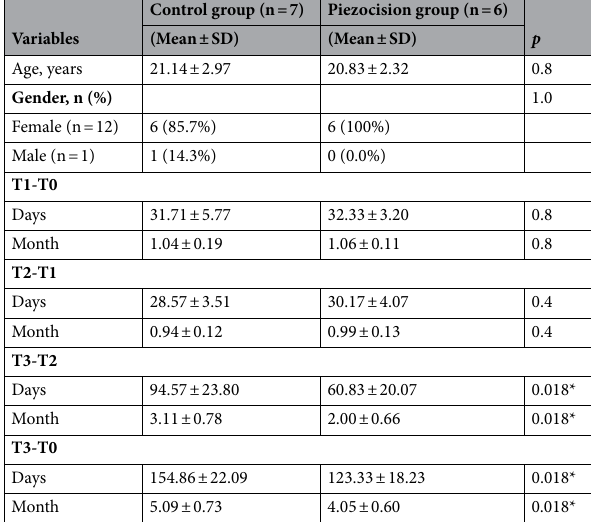
Table 1. Sample demographic and baseline. *Significant.